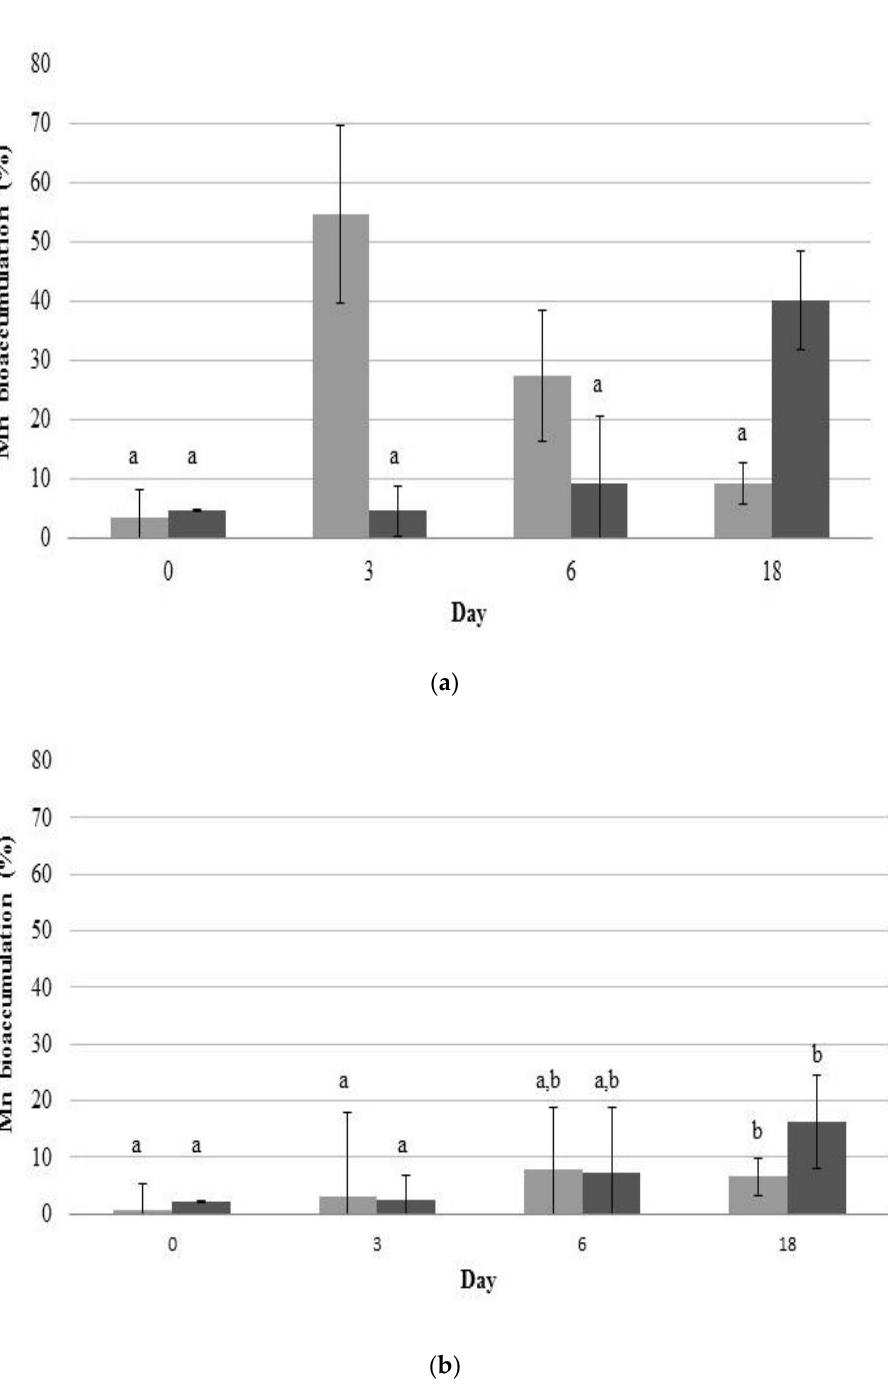
Figure 6. Mn contents accumulated in cell walls of 2De strain ( a ) and its intracellular spaces ( b ). Strain was cultivated in K medium containing 0.5 mM MnO 2 (light grey column) or 4% soil from metallurgical waste heap (dark grey column) at 28 ◦ C. Error bars are ± standard deviation ( n = 3). Values within a column followed by the same letter are not significantly di ff erent at p < 0.05 (LSD).